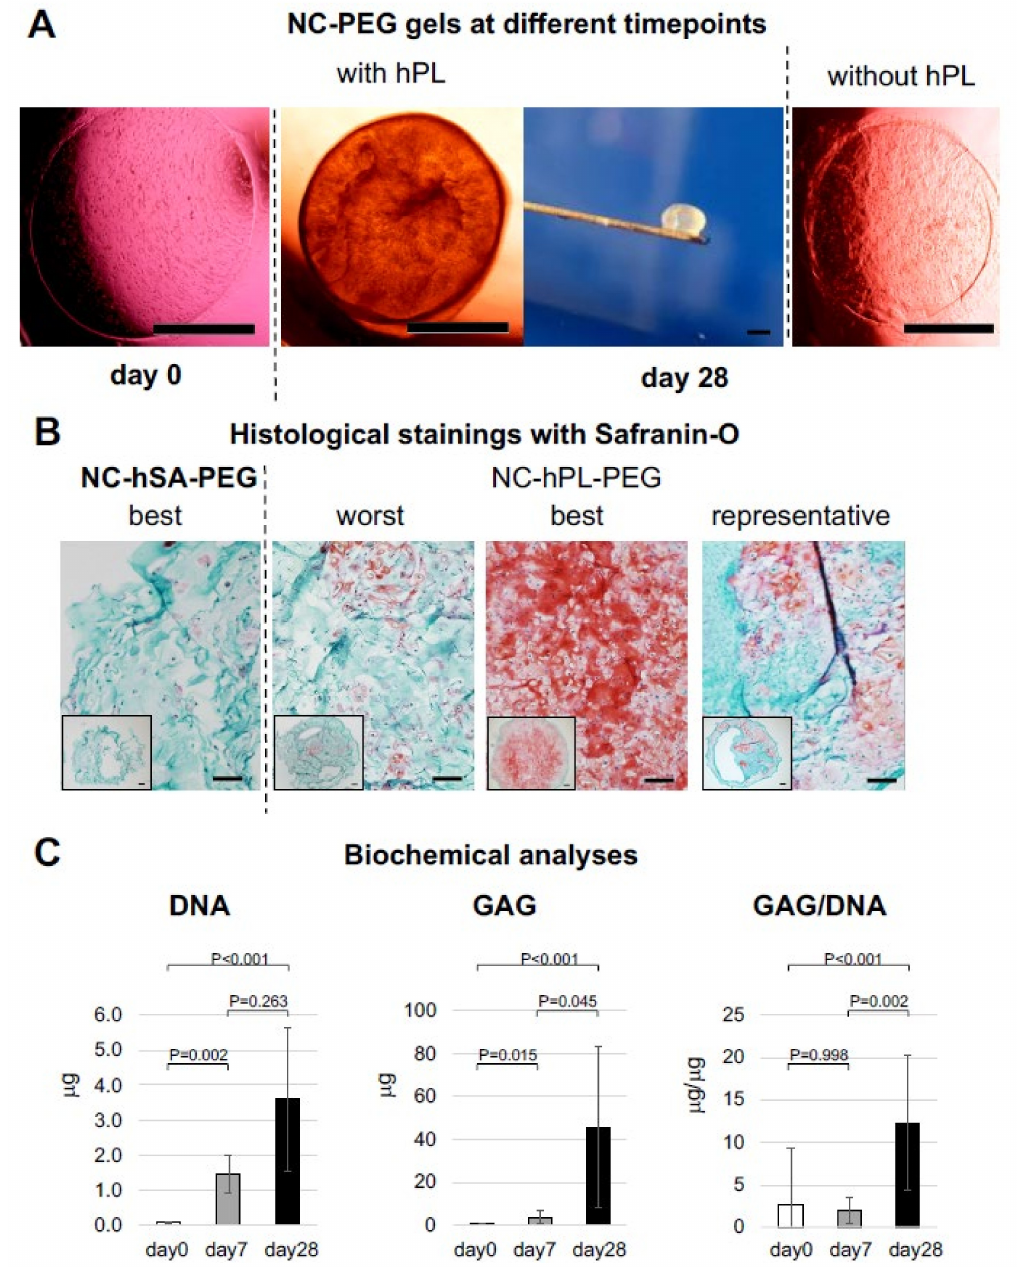
Figure 3. Histological characterization of the constructs generated by culturing nasoseptal chon- drocytes (NC) in Polyethylene glycol (PEG) gel (NC-PEG). Constructs were generated by culturing rapidly isolated NCs in PEG gel in medium containing human serum albumin (NC-hSA-PEG, as control) or human platelet lysate (NC-hPL-PEG, see Materials and Methods for details). ( A ) Macro- scopic appearances of the constructs during the in vitro cultivation. Scale bar = 1 mm. ( B ) Safranin-O staining of a control NC-hSA-PEG (I) construct as well as worst (II), best (III) and representative (IV) quality NC-hPL-PEG constructs generated after 28 days in culture (Bern score values of the corresponding samples are 3.5, 4.5, 8.5, 5.5). Scale bars = 100 µ m. The inserts are low magnification images of the entire constructs. ( C ) Glycosaminoglycans (GAG), DNA and GAG/DNA contents of constructs generated at day 0, 7 and 28, respectively. Values are mean ± SD of results of samples generated with cells from nine different